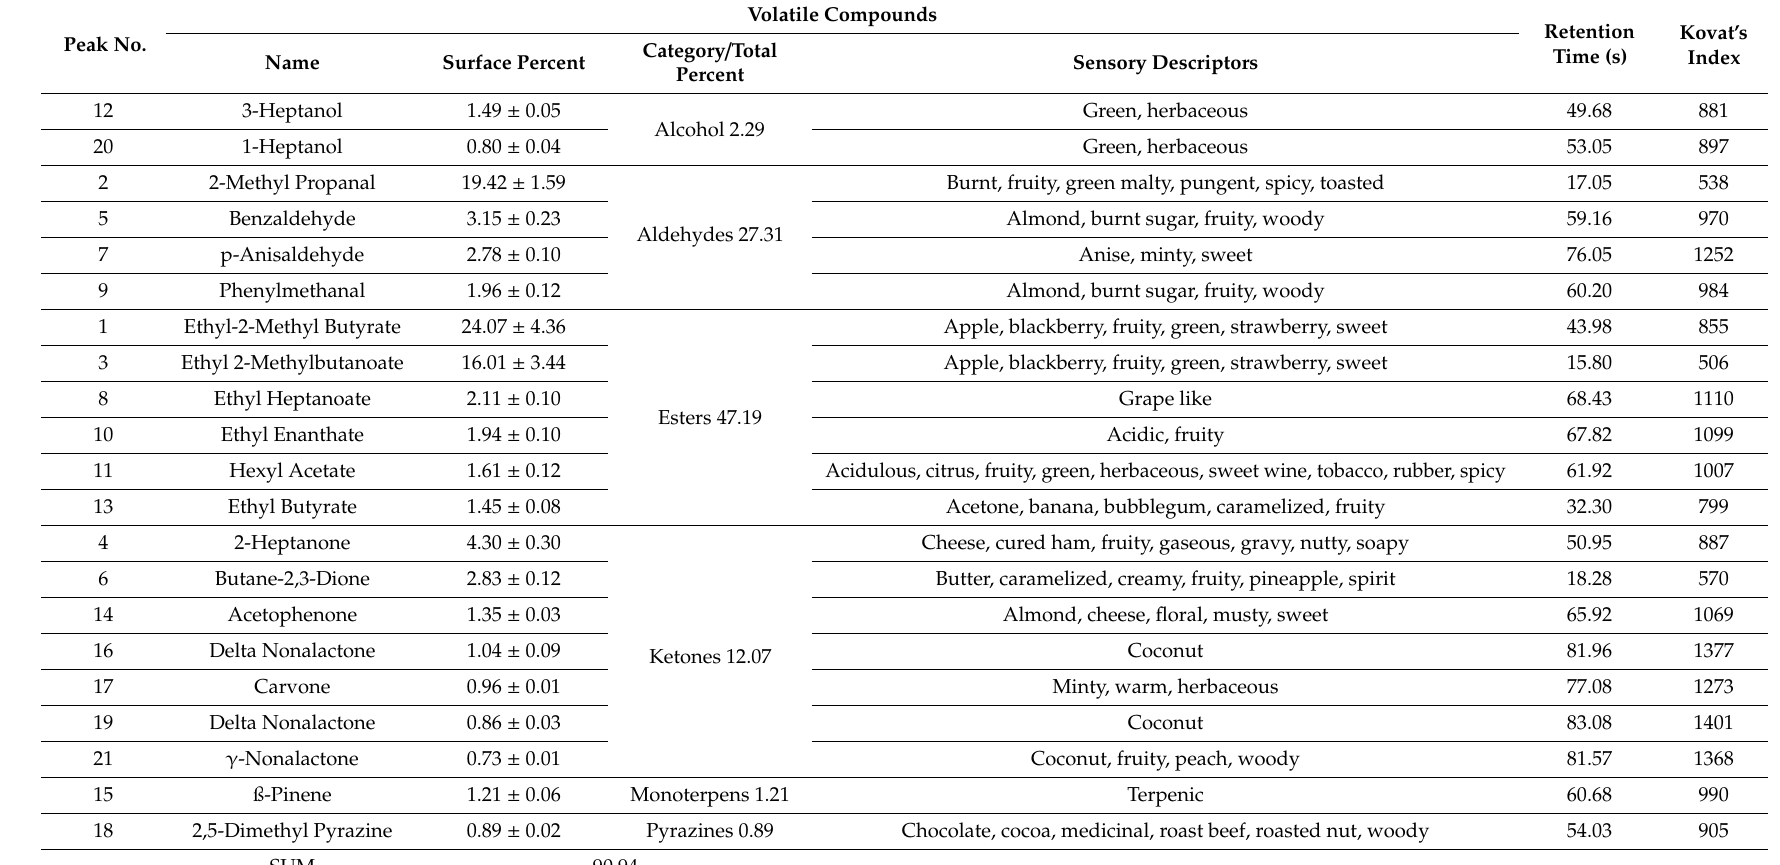
Table 3. Headspace volatile compounds of soybean variety: